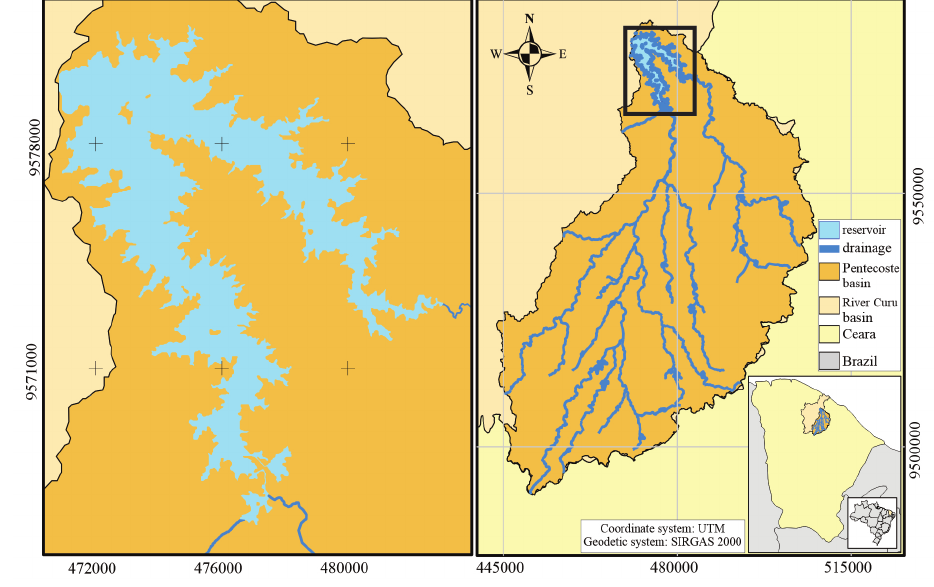
Figure 2. Study area location, Pentecoste reservoir, Brazil. Table 1. Dates of the Landsat 5 TM images and their respective measured water-level altitude. The maximum water-level altitude is 58.00 m.a.s.l. The stored volume (%) is taken as a function of the reservoir storage capacity in 2009 (360 cubic hectometers: